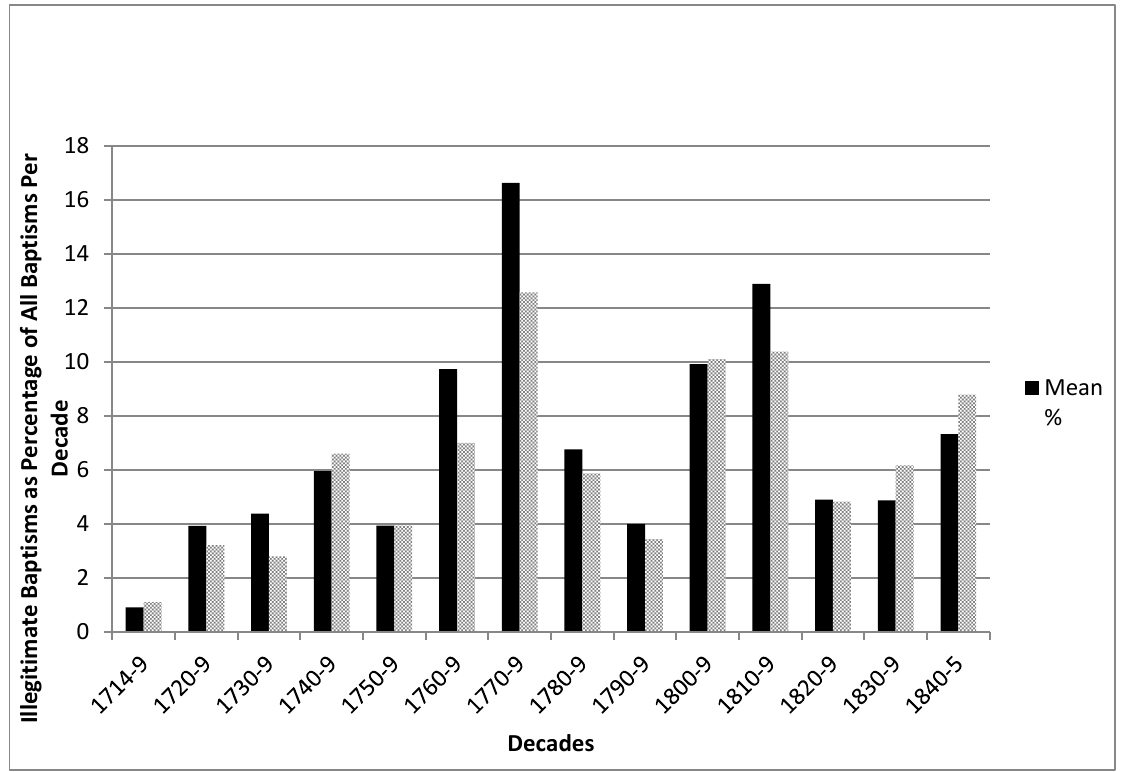
Figure 3. Crude Illegitimacy Ratio, Compared to Illegitimacy Ratio Calculated Excluding Years of Potential Under-Recording, Butleigh, Somerset, 1714–1845.